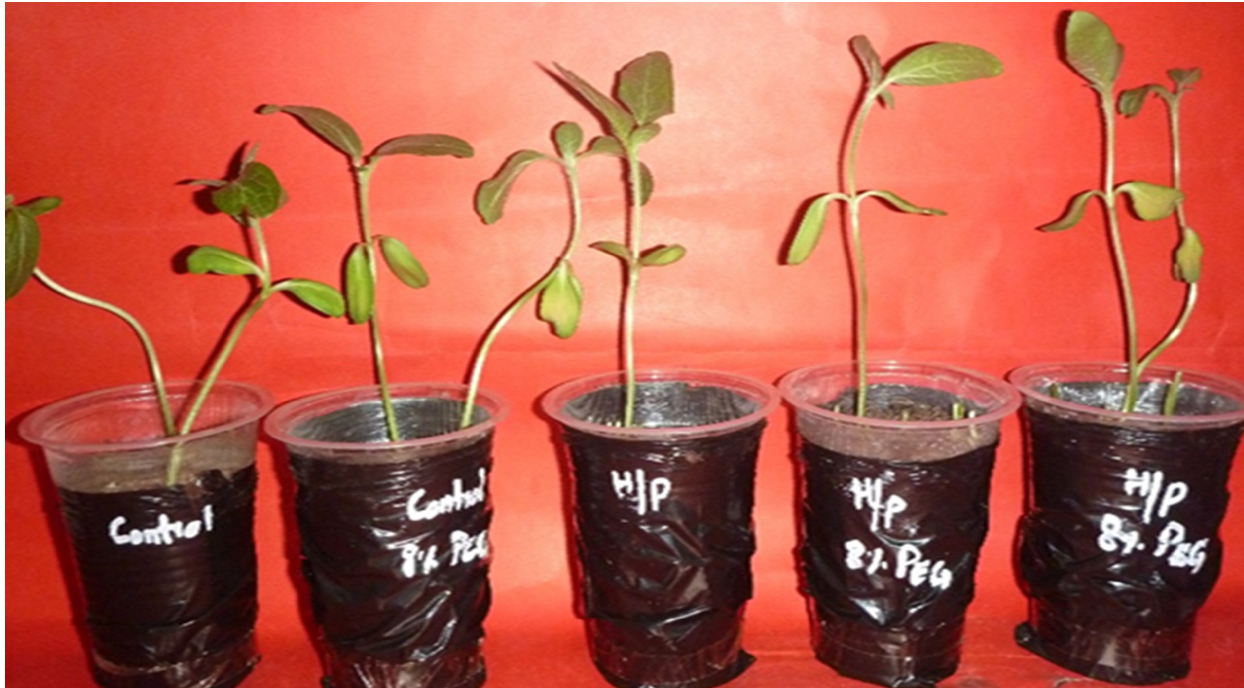
Figure 3. Effect of endophytic F. proliferatum on the growth of sunflower seedlings under normal (optimum water) and drought (8% PEG) conditions. Seedlings were grown for 12 days and then exposed to different treatments of 8% PEG at three ‐ day intervals.